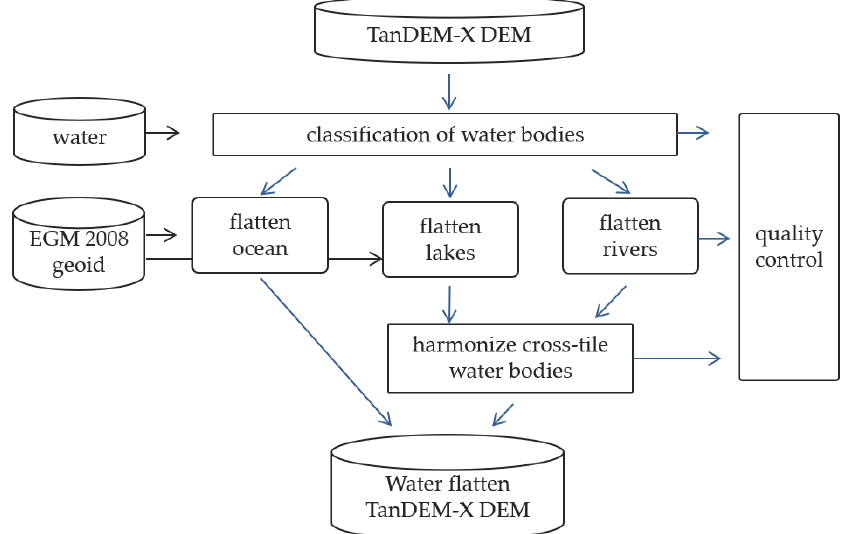
Figure 9. Water body editing